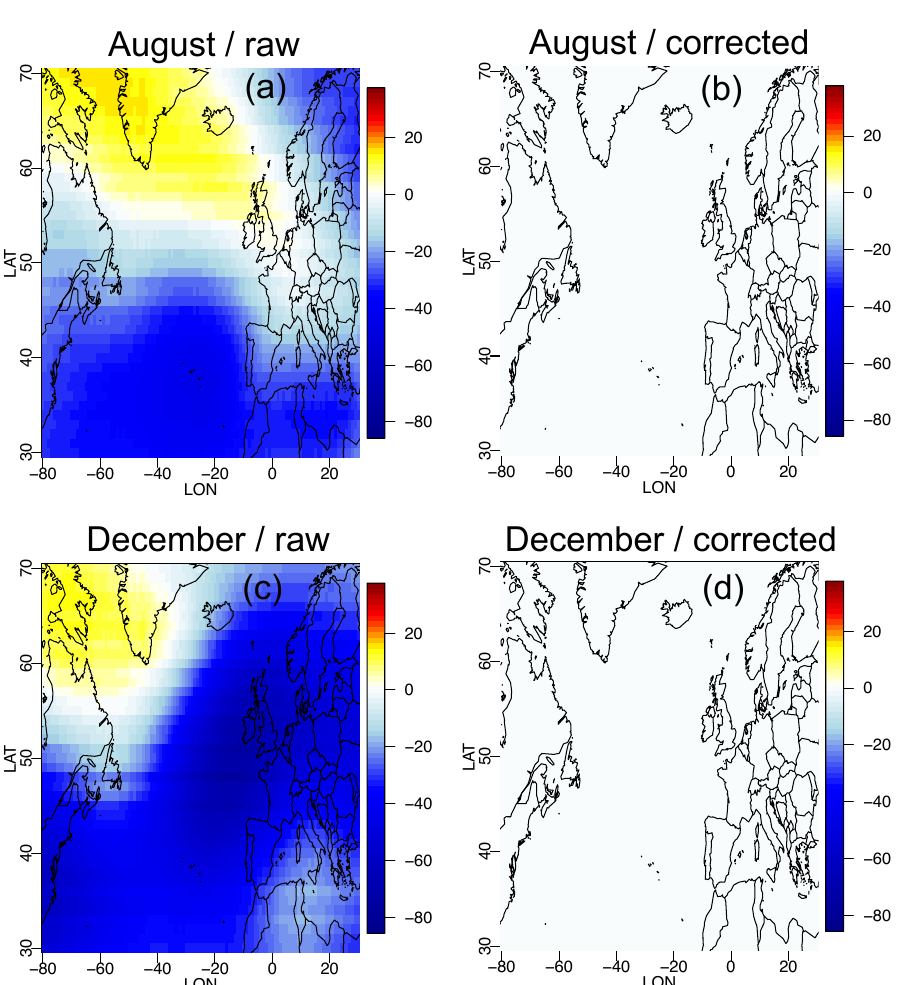
Figure A1. ( a ) Mean Z500 bias of 11 CMPI6 simulations (in m) for August. ( b ) Mean Z500 bias after bias correction for Z500 in August (in m). ( c ) Mean Z500 bias of 11 CMPI6 simulations (in m) for December. ( d ) Mean Z500 bias after bias correction for Z500 in December (in